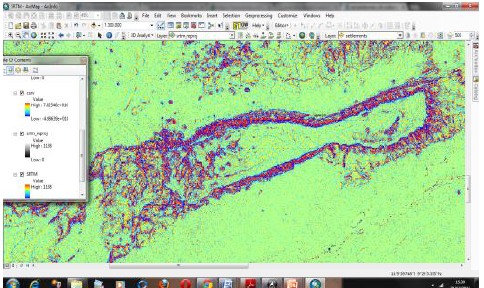
Figure 10. Curvature map of parts of the area around Dadiya Syncline